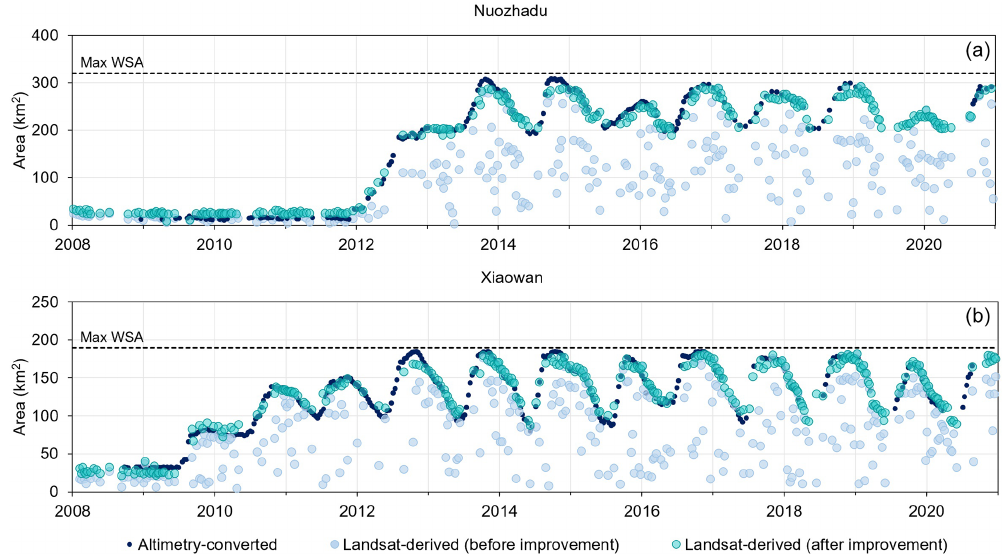
Figure 8. Water surface area of Nuozhadu (a) and Xiaowan (b) reservoirs. Note the drastic difference in WSA values before (light blue points) and after (cyan points) the classification improvement. The corrected values of WSA are well in agreement with those obtained through altimetry water level data and E – A curves (dark blue